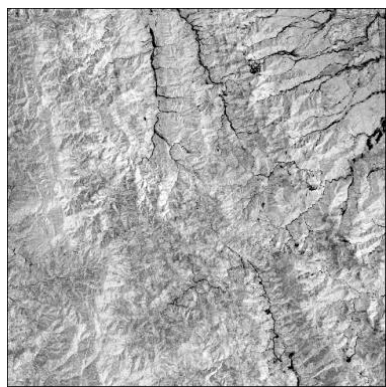
Figure 3. Maximum NDVI array